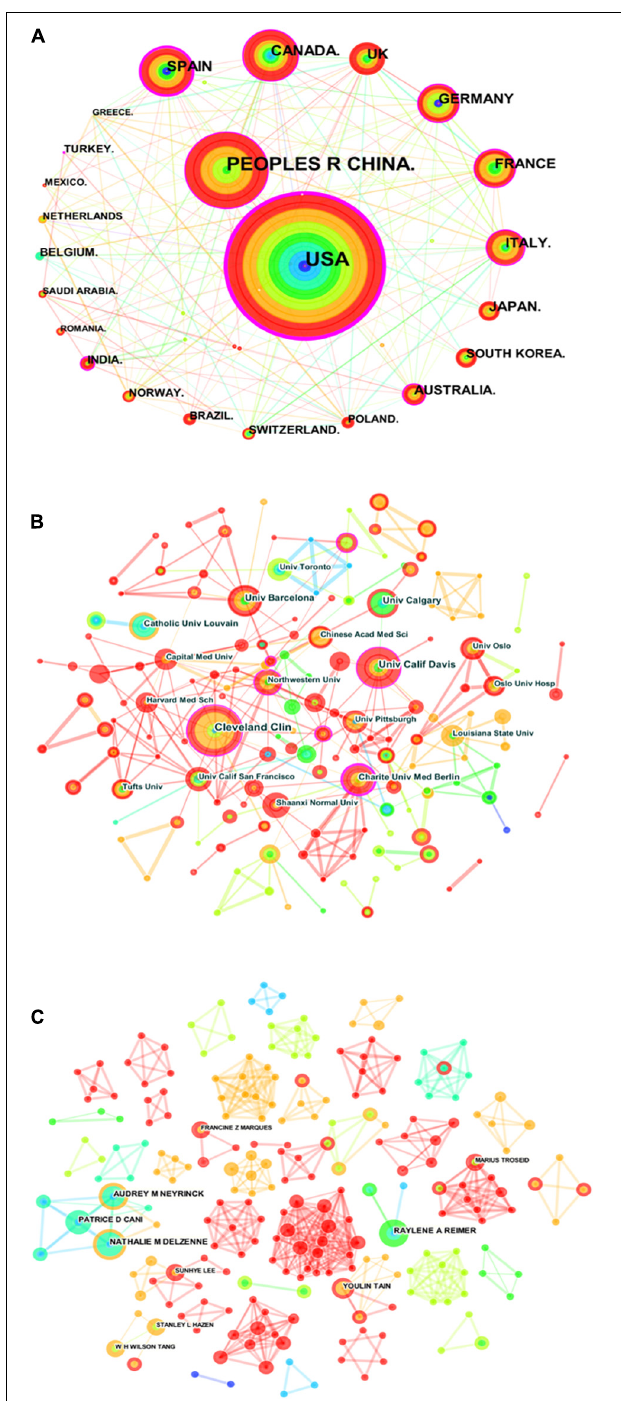
FIGURE 4 | Visualization knowledge maps of the scientific collaboration network for gut microbiota research in the heart failure field between 2006 and 2021. (A) Inter-country collaboration network map. (B) Inter-institutional collaborative network map. (C) Inter-author collaborative network map. Circle node on the map represents a country, institute, or author, while link lines between nodes indicate collaborative relationships. The more published articles are, the larger their node area is. The outermost purple ring denotes the centrality level, and the nodes with high centrality are in the core